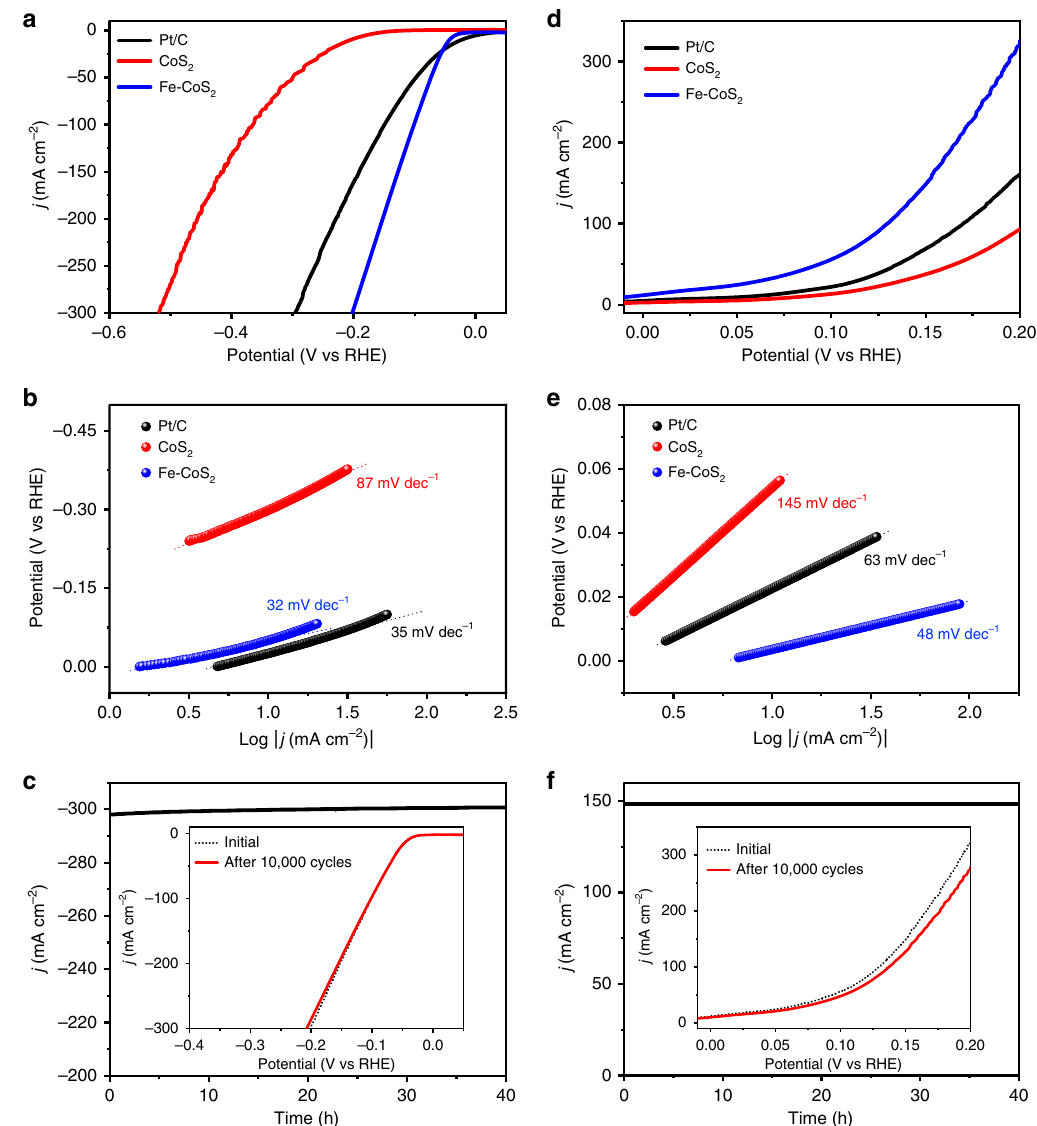
Fig. 2 Electrochemical performances of the Fe-CoS 2 nanosheets for HER and HzOR in three-electrode cells containing alkaline electrolytes at room temperature. a HER polarization curves of 20 wt.% Pt/C, the pristine CoS 2 nanosheets and the Fe-CoS 2 ones. b Tafel plots from a . c Chronoamperometric curve recorded on the Fe-CoS 2 nanosheets for 40 h at a constant working potential of − 0.2 V for HER, in which the onset value of current density is 298 mA cm − 2 , very close to the one (296 mA cm − 2 ) at − 0.2 V in a . The meanings of d – f are the same as those of a – c , but they are for HzOR. The used working potential in f is 0.15 V. The insets in c , f are the HER and HzOR polarization curves of the Fe-CoS 2 nanosheets before and after the nanosheets experienced 10,000 potential cycles, respectively. The electrolytes for HER and HzOR were 1.0 M KOH and 1.0 M KOH with 0.1 M hydrazine, respectively (see Methods for more